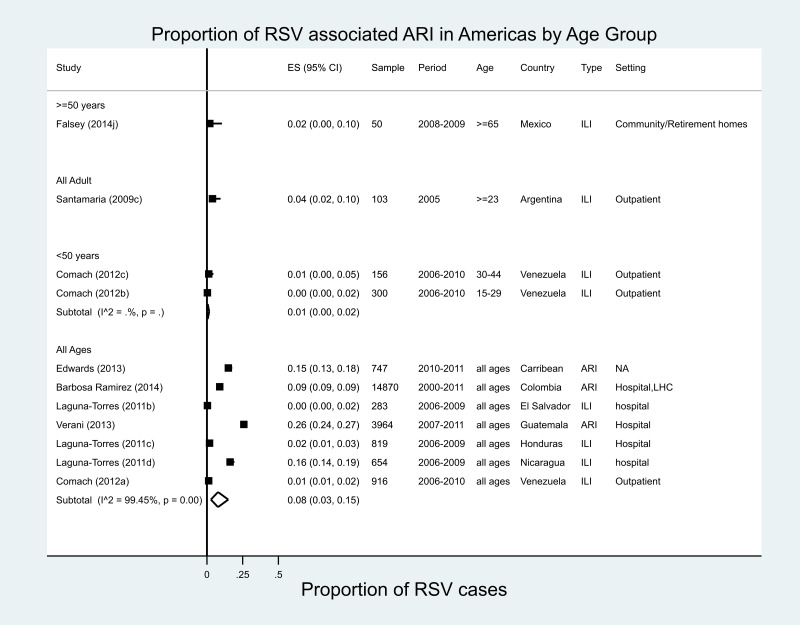
Proportion of RSV-associated ARI/ILI in the Americas region.